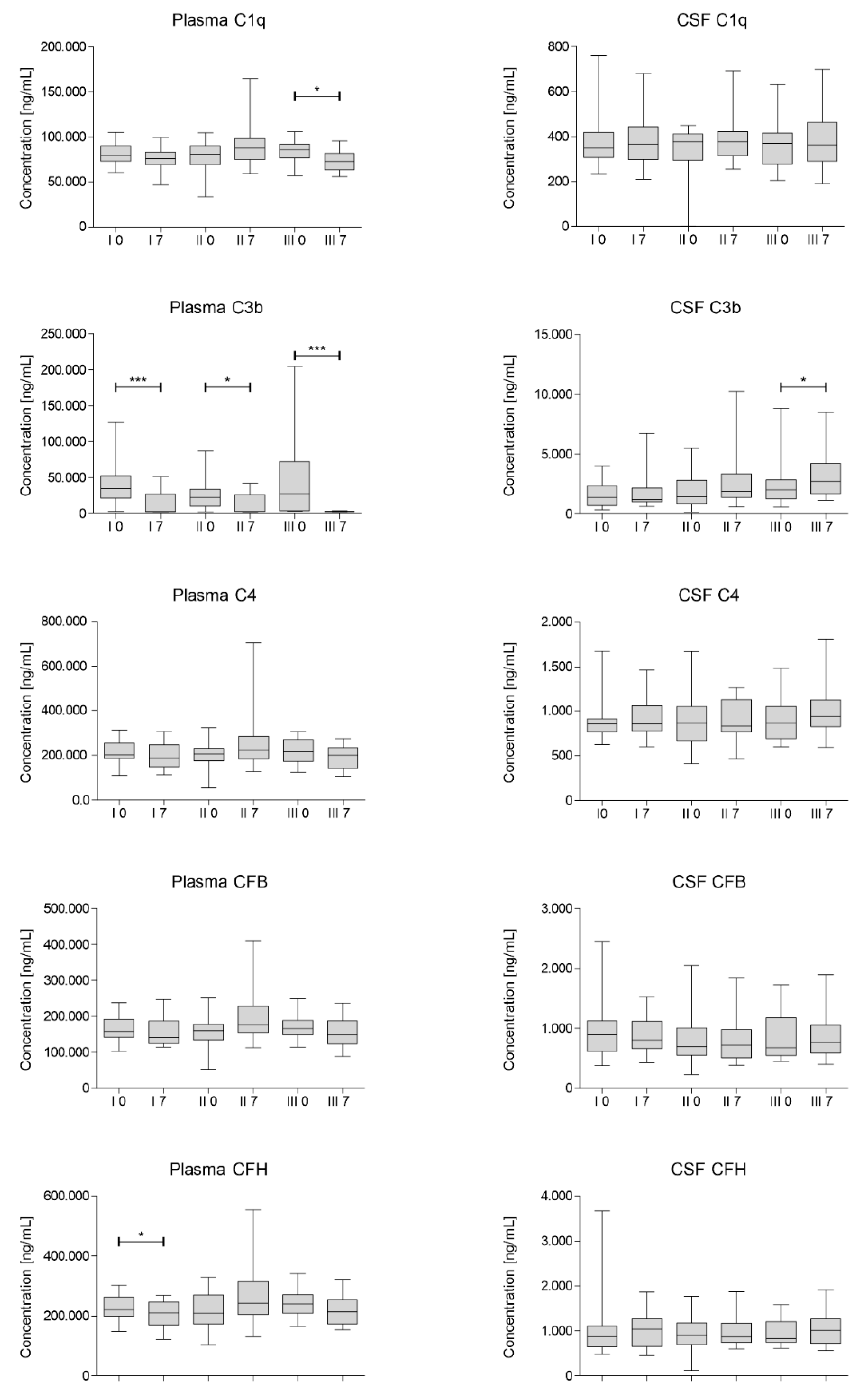
Figure 2. Multiplex Luminex median concentration of selected complement components assessed for each cell administration (I, II, III) on day 0 and 7. CSF—cerebrospinal fluid; CFH—complement factor H; CFB—complement factor H. Significance of the changes between analyzed timepoints in comparison to day 0 of each administration was assessed using Wilcoxon signed-rank test. Level of significance—* p < 0.05, *** p < 0.001.